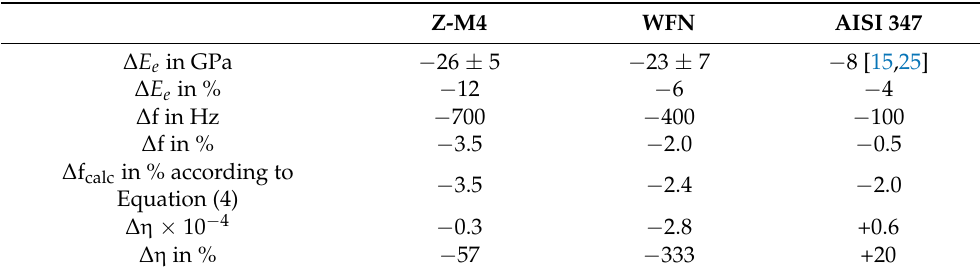
Table 8. Changes in loss coefficient, elastic modulus and Eigenfrequency, of Z-M4, WFN and AISI 347 during the